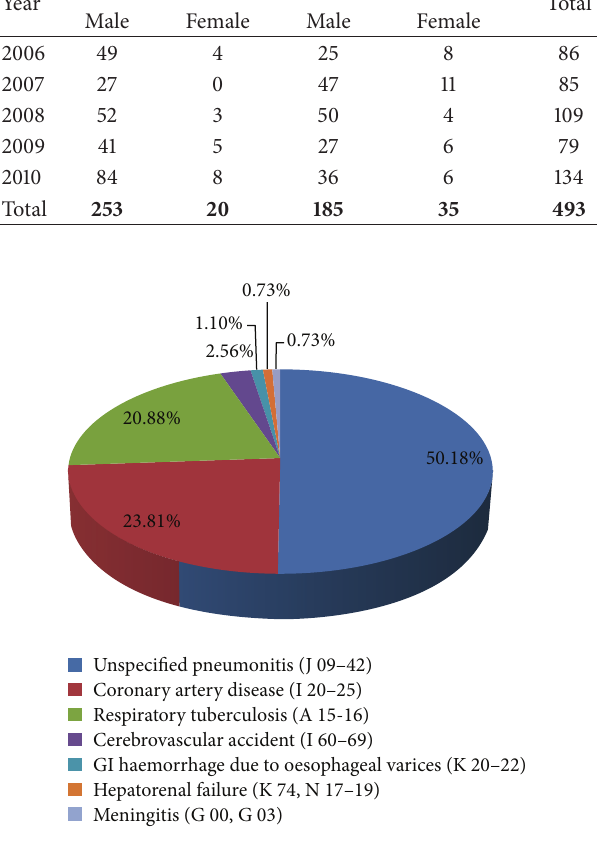
Figure 1: Distribution of natural causes of death among 50+